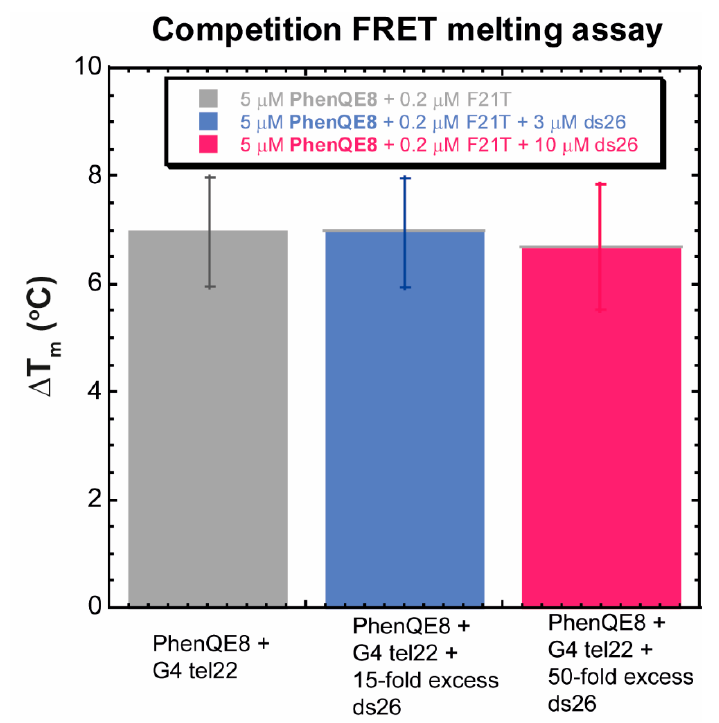
Figure 4. Competition DNA FRET melting experiments for PhenQE8 at a 5 μ M concentration with 0.2 μ M G4 sequence Tel22 (10 mM lithium cacodylate, 90 mM LiCl, 10 mM KCl) in the absence (grey) and presence (blue and dark pink) of competitor dsDNA sequence ds26: 3 μ M, 15-fold DNA excess (blue) and 10 μ M, 50-fold DNA excess (dark pink).